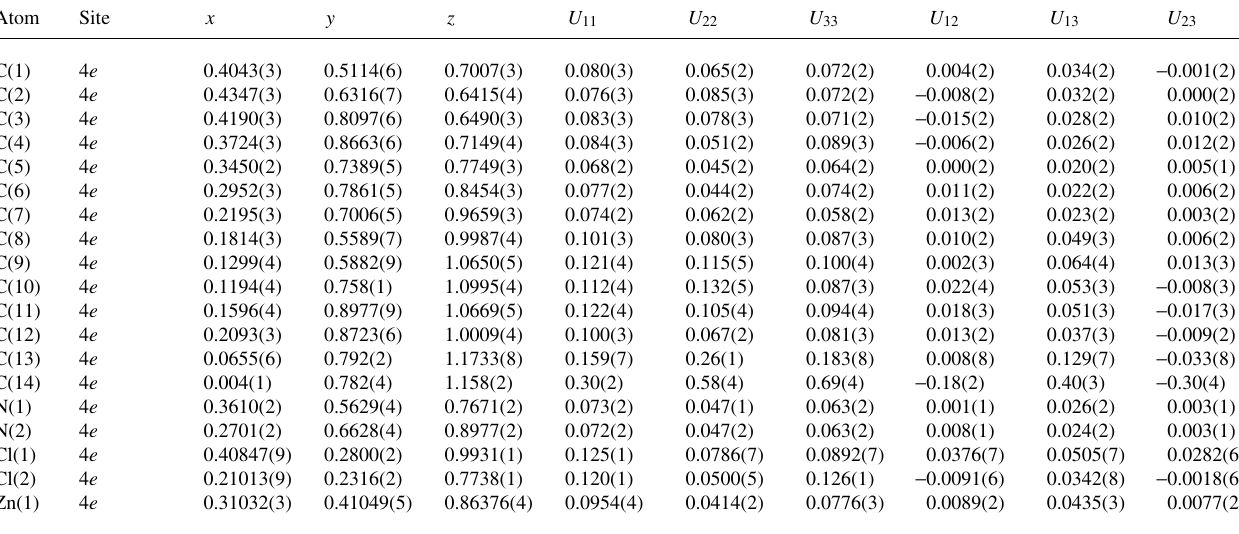
Table 3. Atomic coordinates and displacement parameters (in Å 2 )